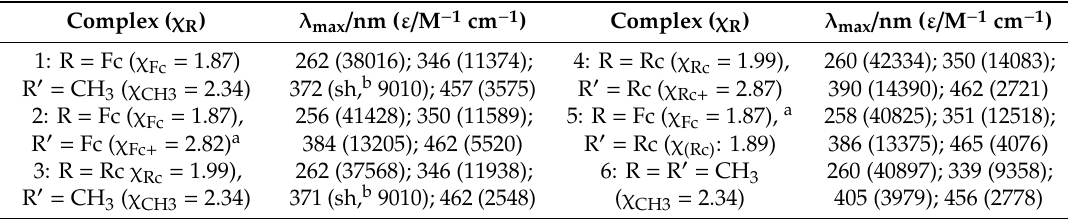
Table 2. Wavelengths of absorption maxima ( λ max ) and extinction coe ffi cients in brackets at these wavelengths, ε , for [(ppy) 2 Ir(RCOCHCOR (cid:48) )] complexes 1 – 6 in CH 2 Cl 2 and Gordy scale group electronegativities, χ R , for R and R (cid:48)